Question: Express in one sentence what the figure is showing.
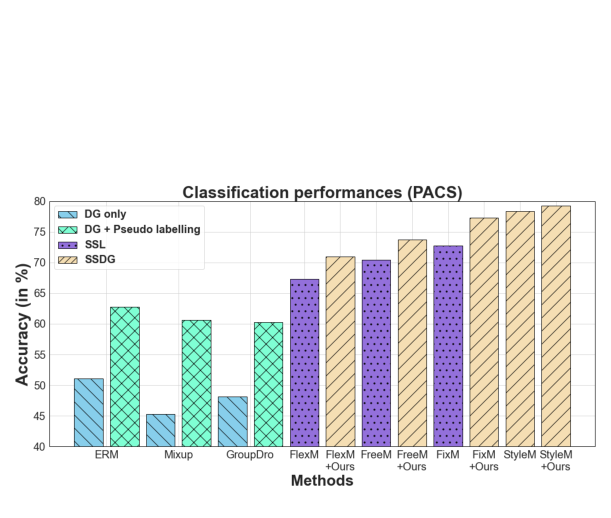
Answer: Recognition performance comparison between different DG, DG combined with pseudo-labeling, SSL methods and ours in SSDG settings. Here, GD - GroupDro, FlexM - FlexMatch, FreeM - FreeMatch, FixM - FixMatch and StyleM - StyleMatch.